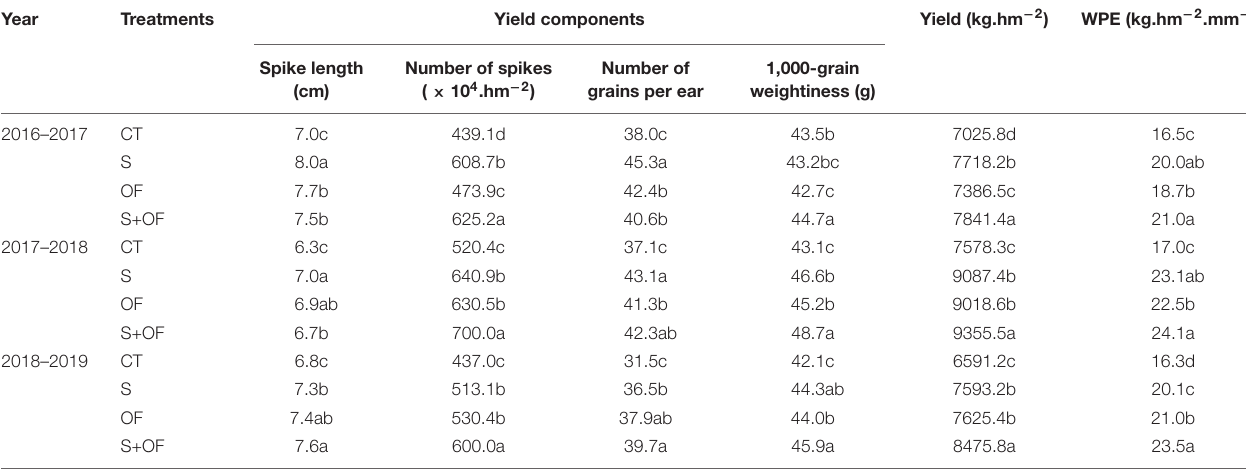
TABLE 2 | Differences in spike length, number of spikes, number of grains per ear, kilo-grain weightiness, yield and WPE of wheat between subsoiling, organic fertilizer and subsoiling combined with organic fertilizer in three seasons of 2016–2019.